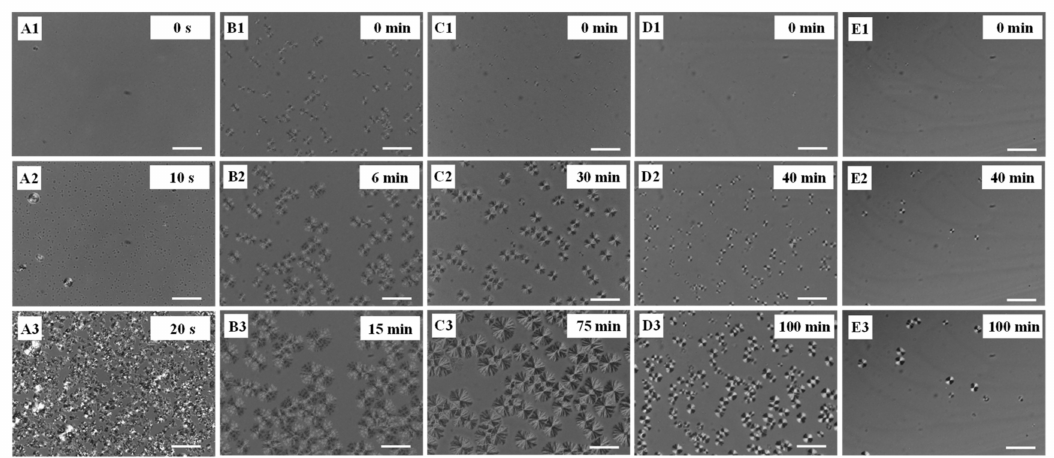
Figure 2. POM images of neat PVDF ( A1 – A3 ), PVDF/PMMA-1( B1 – B3 ), PVDF/PMMA-2 ( C1 – C3 ), PVDF/PMMA-3 ( D1 – D3 ), and PVDF/PMMA-4 ( E1 – E3 ) isothermal crystallized for the indicated time at 150 ◦ C. The scale bar is 50 µ m.